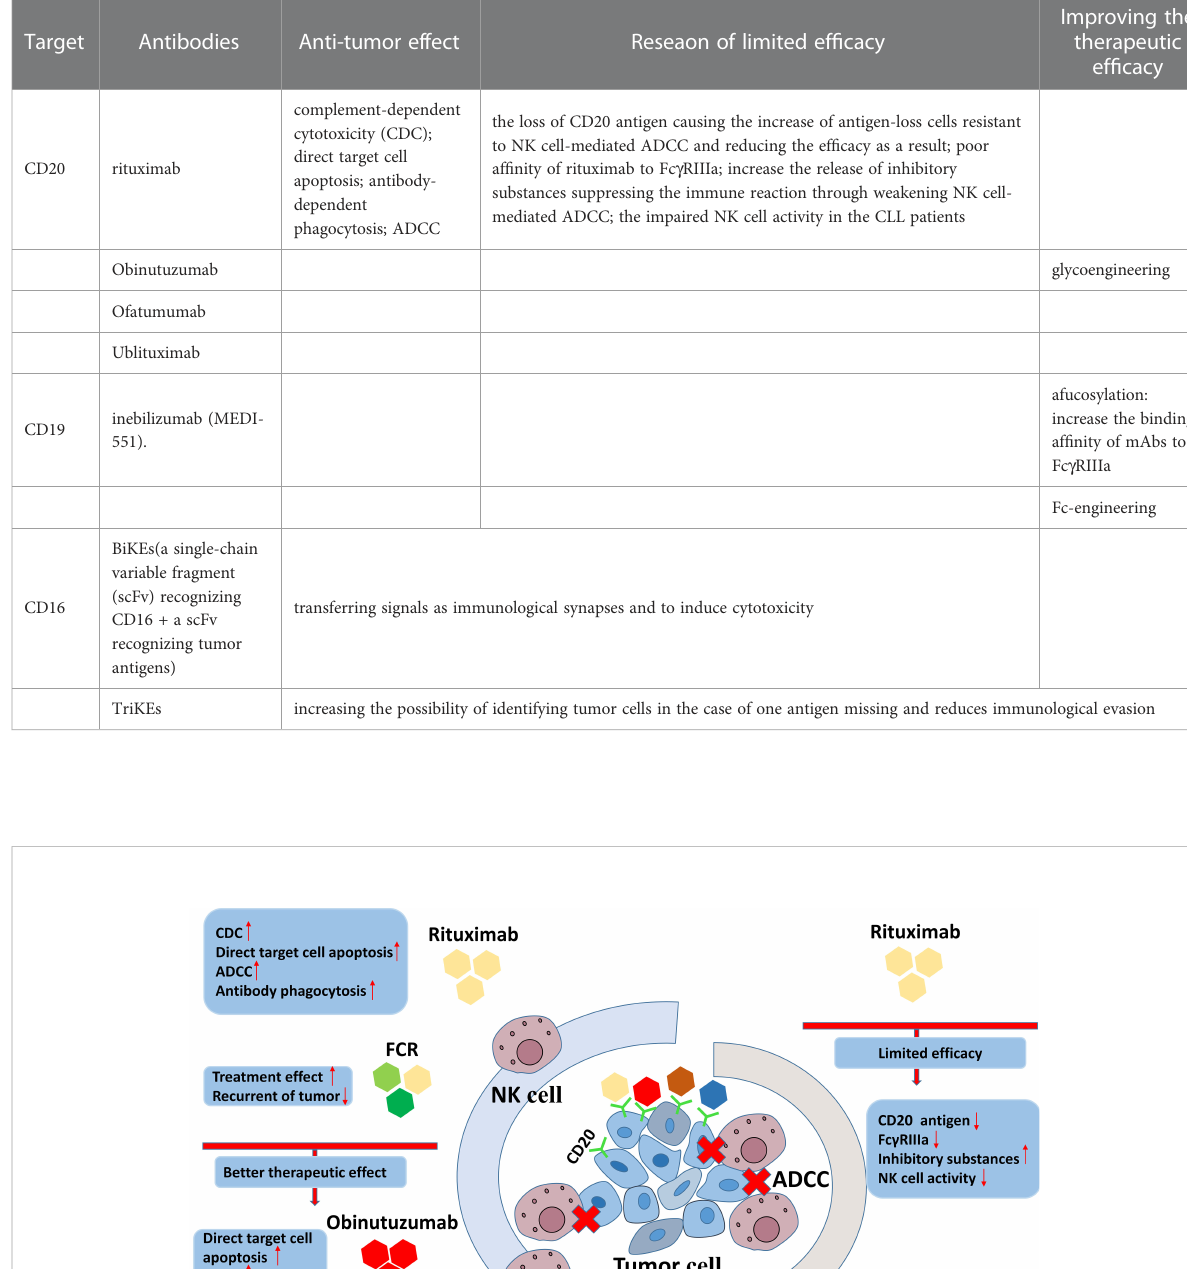
TABLE 1 Tumor-speci fi c antibody